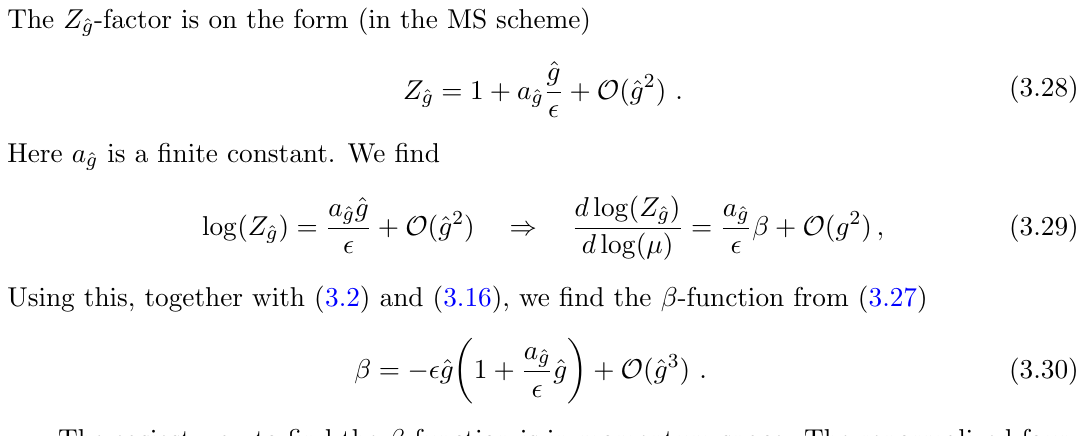
Figure 2 . The RG (cid:13)ow of the theory for positive (cid:15) , where ^ g (cid:3) = 12 (cid:25)(cid:15) the IR to